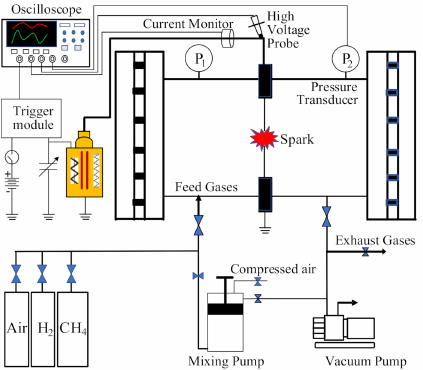
Figure 1. A schematic diagram of the experimental